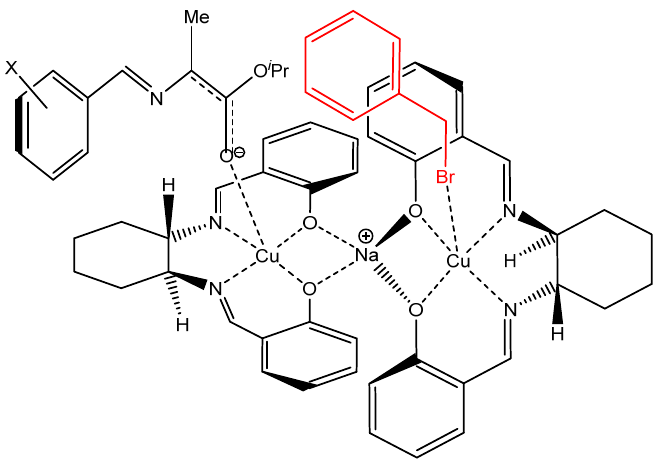
Figure 5. Proposed structure of the complex formed by the carbanion of the substrate and a chiral salen metal complex.